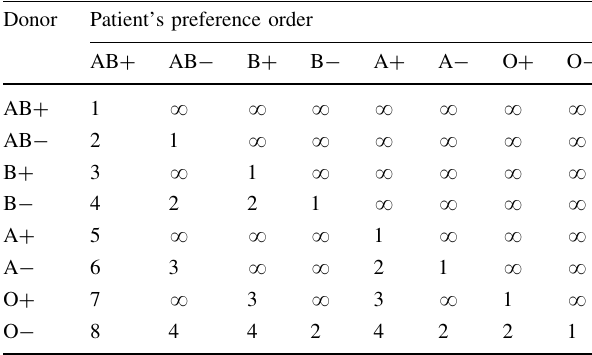
Table 8 Assumed preference order of possible ABO/ Rh (D)-com- patible substitutions for red blood cells. Source Lang